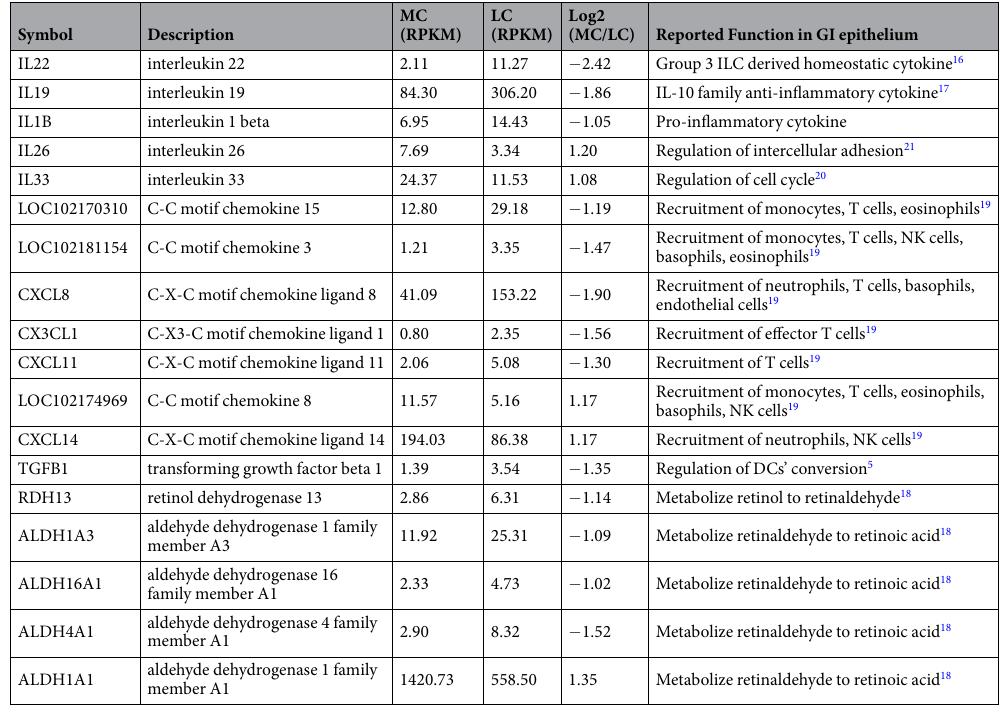
Table 2. Differentially expressed genes encoding interleukins, transforming growth factors and